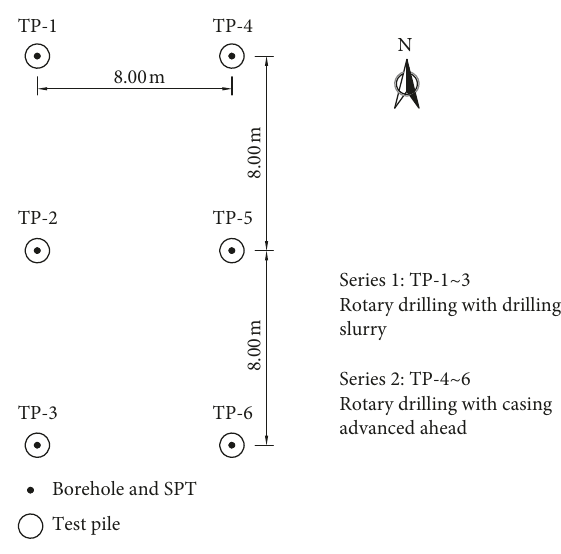
Figure 2: Layout of the test piles and boreholes.